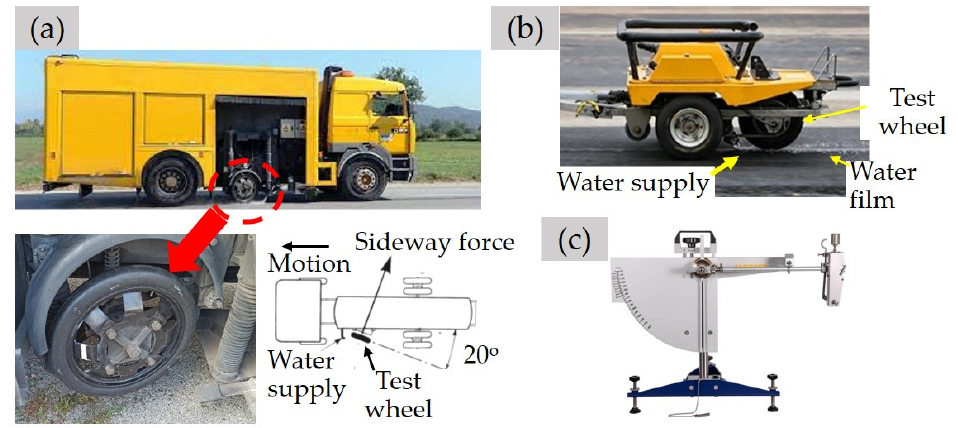
Figure 7. Typical systems for skid resistance measurements: ( a ) SCRIM system, ( b ) GripTester system (trailer-towed) and ( c ) a portable BPT system.